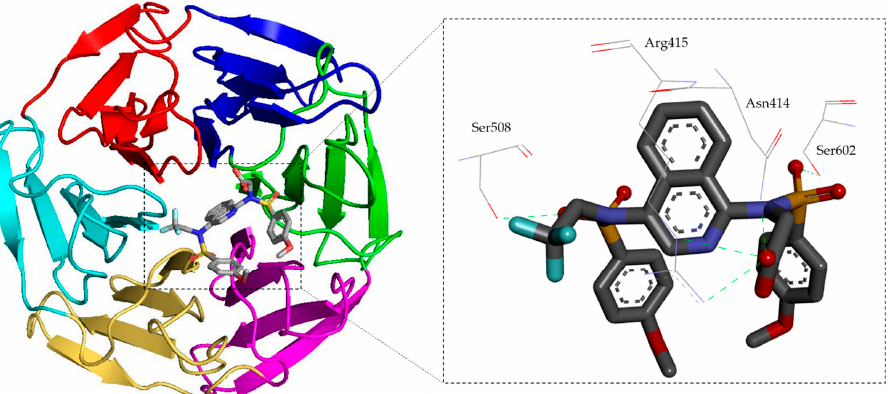
Figure 3. Crystal structure of compound 14 in complex with human Keap1 Kelch domain (pdb #6UF0). Overall structure of Keap1 Kelch domain in complex with compound 14 and details of interaction (inset).